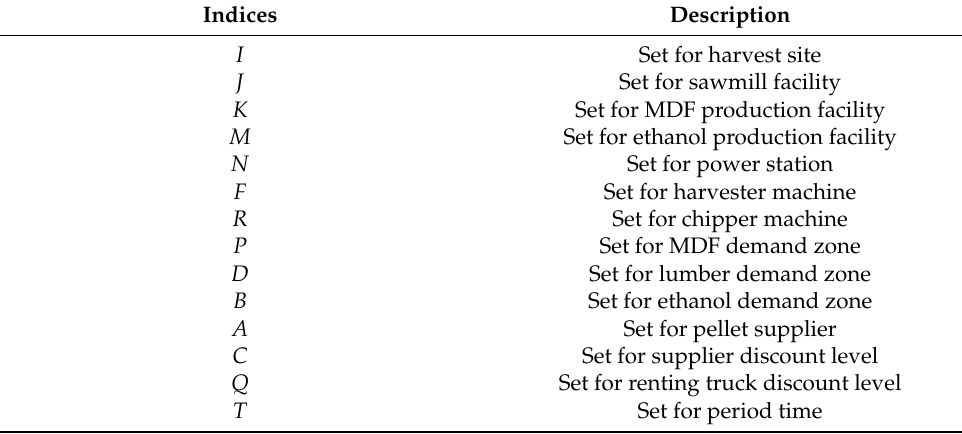
Table 1. Indices of mathematical